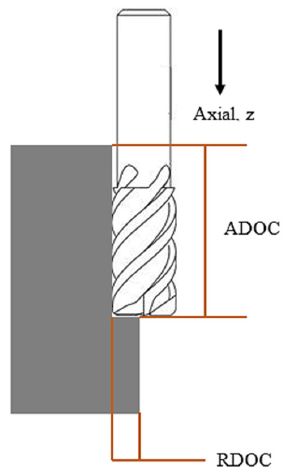
Figure 2. Schematic diagram of the down ‐ cut high speed milling. Table 4. Tool